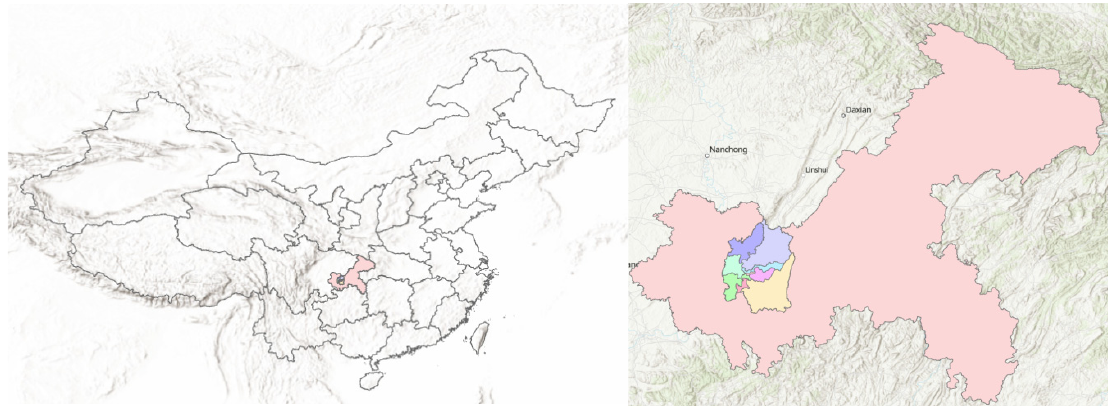
Figure 1. Map of Chongqing, China.